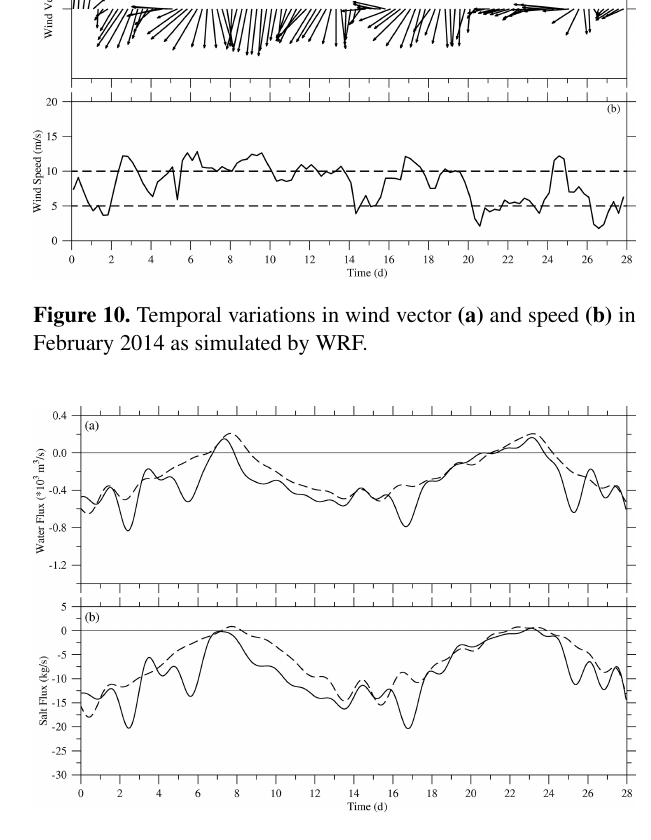
Figure 11. Temporal variations in residual water flux (a) and salt flux (b) across sec2 in the northern branch in February 2014. Dashed line – experiment 1; solid line – experiment 2. A positive value represents seaward flux, and a negative value represents land- ward